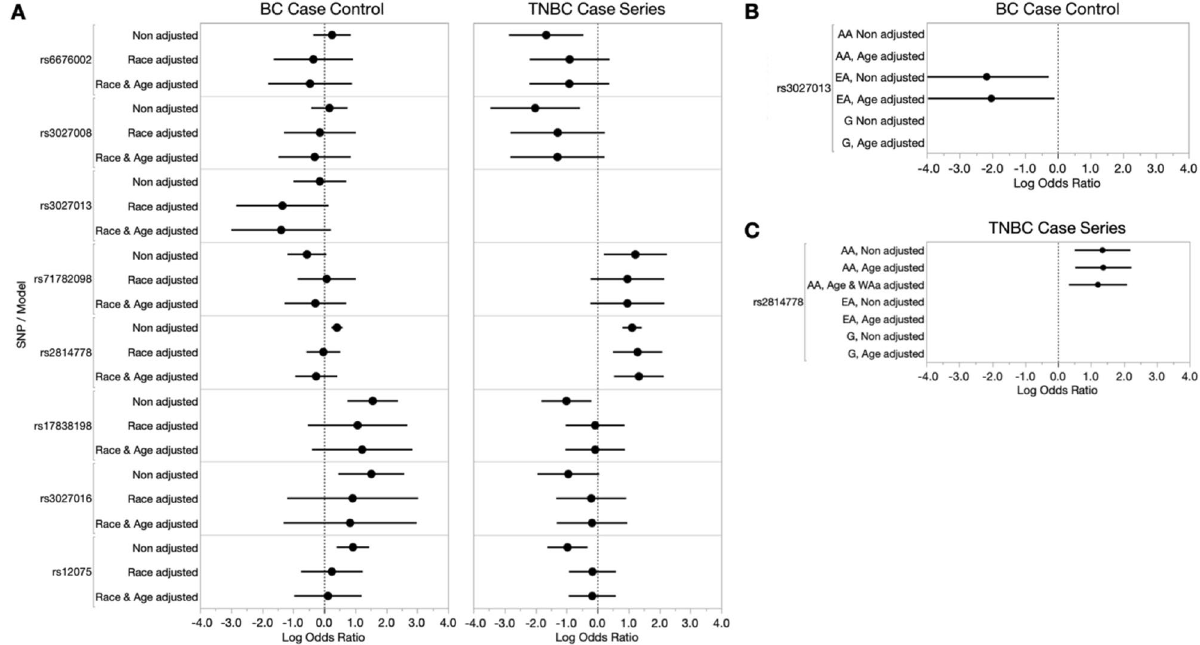
Figure 2. Breast cancer case–control and TNBC case-series risk analysis of DARC/ACKR1 alleles among our ICSBCS cohort. ( A ) The log odds ratio (x-axis) depicting SNV association with BC- or TNBC-risk among all samples is shown in non-adjusted models, and models adjusted for covariates (race and age) in our BC case–control analysis (left) and TNBC case-series analysis (right). ( B ) Within SIR BC case–control analysis for rs3027013. ( C ) Within SIR TNBC case-series analysis for rs2814778. For both ( B ) and ( C ), non-adjusted and age-adjusted models within SIR groups are shown for African Americans (AA), European Americans (EA), and